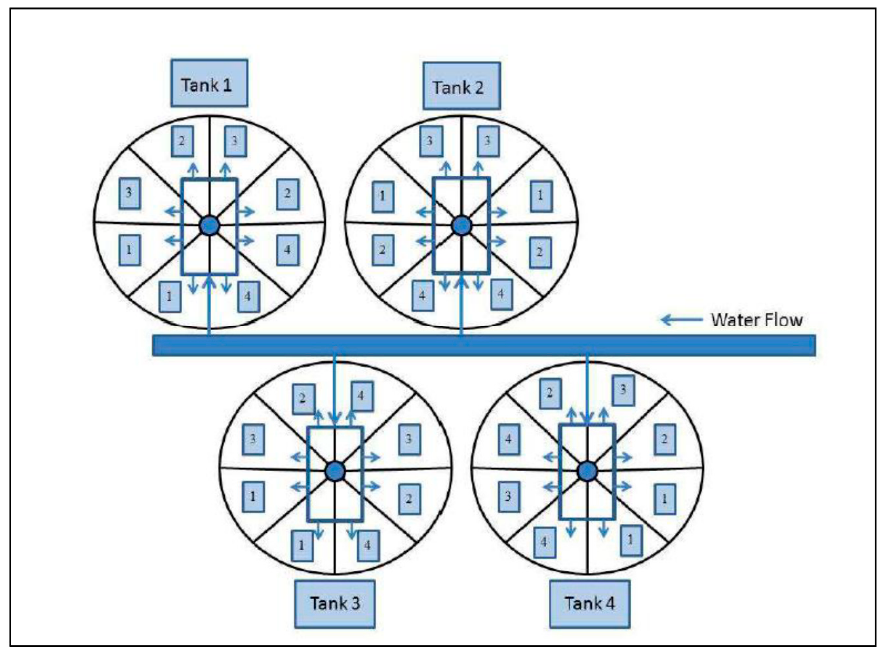
Figure 1. Schematic design of the larval chemotherapeutant study. Each 1.2 m diameter of tank held 400 fish from hatchery and wild naturally produced fish, which were divided into eight equal sized partitions (50 fish per partition). There were four tanks. Each partition was randomly assigned to one of four weekly treatment types, each with two replicates. Chemotherapeutant treatments in- cluded: (1) 60 min, 15 ppm CT bath; (2) 15 min, 60 ppm H 2 O 2 ; (3) 3 parts per thousand (ppt) NaCl - bath for 15 min followed 24 h later by a 15 min, 60 ppm H 2 O 2 bath labeled as NaCl/H 2 O 2 ; and (4) a control (no chemical treatment) labeled as CTRL. Arrows indicate directions of water